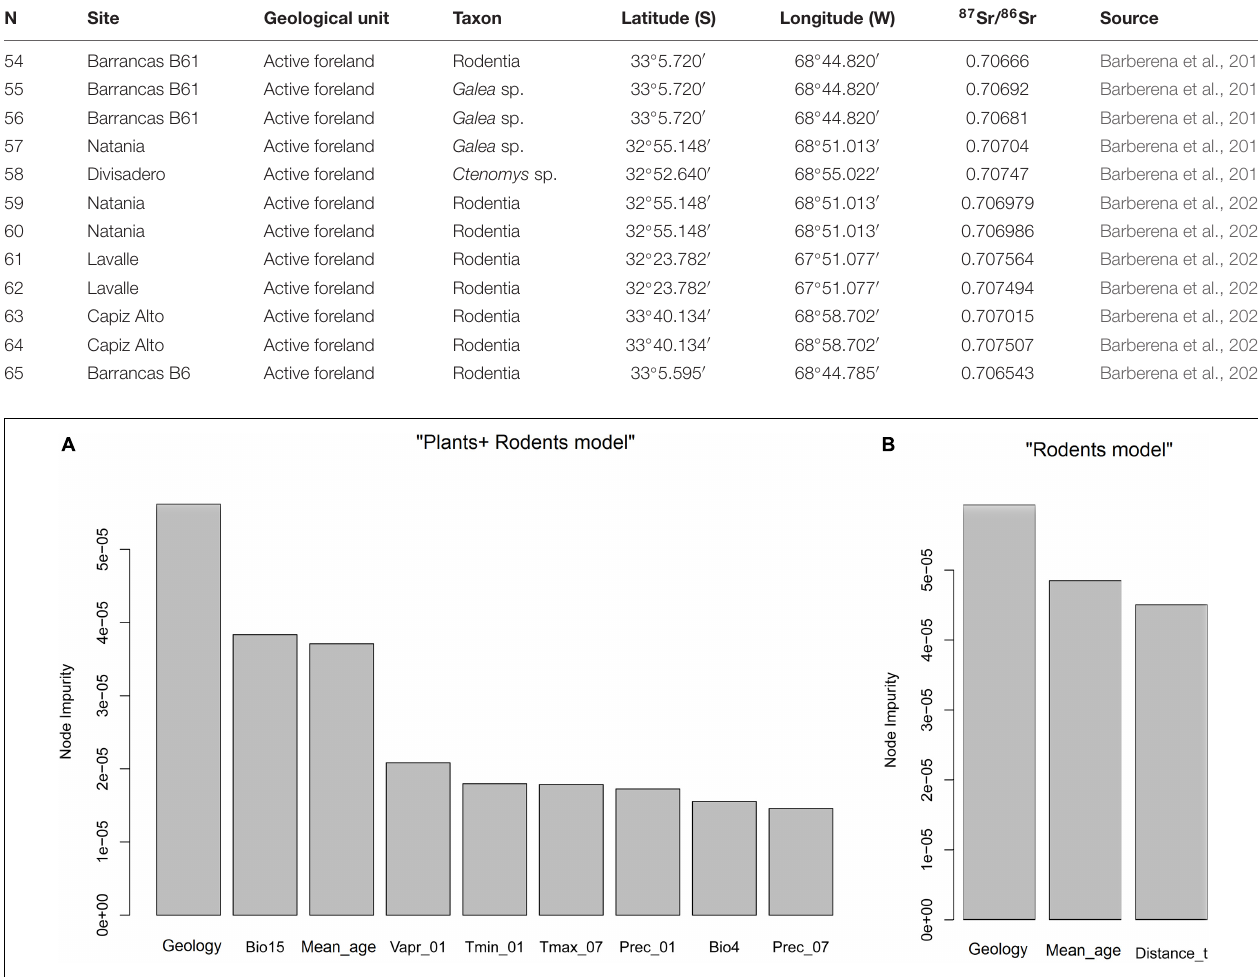
(Geological Province and Mean-age), while the third (Distance to coast) would be related with the decreasing incidence of marine strontium—0.709202 ± 0.000003—(Kuznetsov et al., 2012) with increasing distance from the coast (Alonzi et al., 2020). Importantly, in the “Plants + Rodents” model several bioclimatic of temperature seasonality (Bio15).